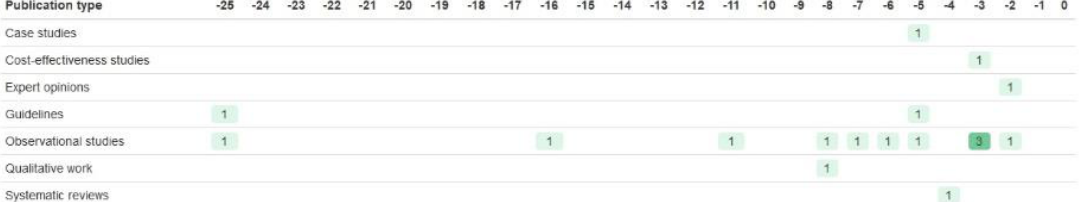
Figure 2. Evidence cited by the TARGET trial to justify inclusion of the TPMT biomarker, relative to the publication of the 2005 protocol [47].